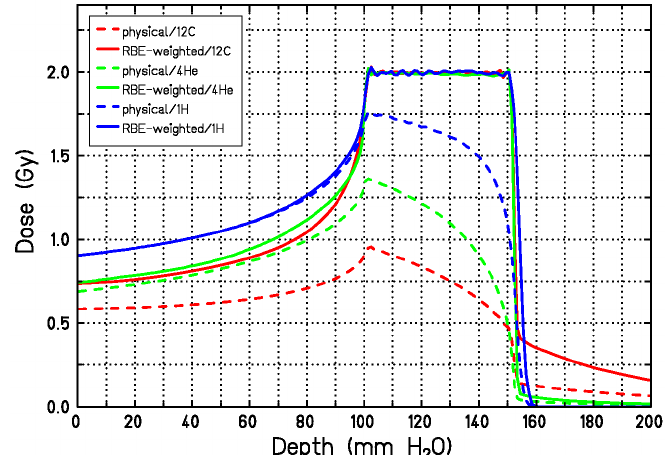
Figure 7. Physical (dashed lines) and RBE-weighted dose (solid lines) for a single 5-cm SOBP using protons, He- or C-ions. The physical dose shape is calculated with LEM-IV to achieve the same RBE-weighted dose in the target region for all ions. Figure modified from [78].